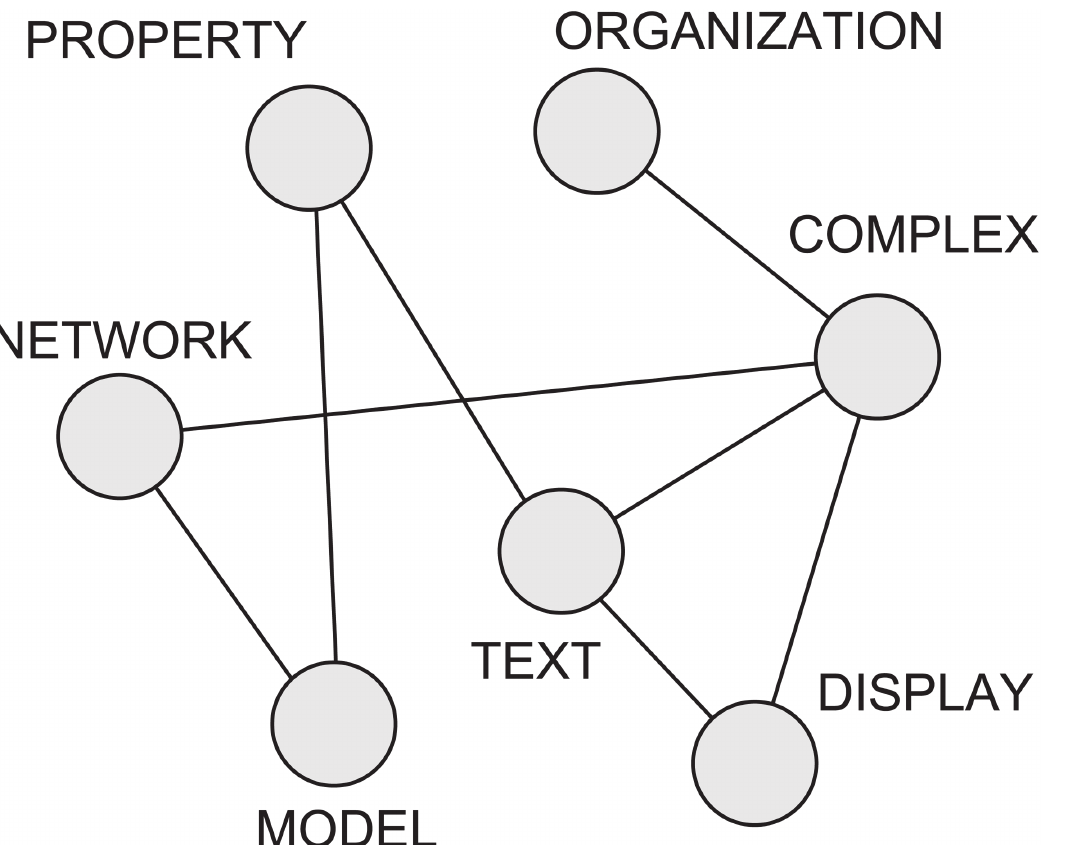
Fig 1. Example of adjacency network. In this example, the network was created from the extract: “ Complex networks model several properties of texts. A complex text displays a complex organization ” . After the pre-processing step, words are mapped into nodes, which in turn are connected if the respective words appeared at least once as neighbors.